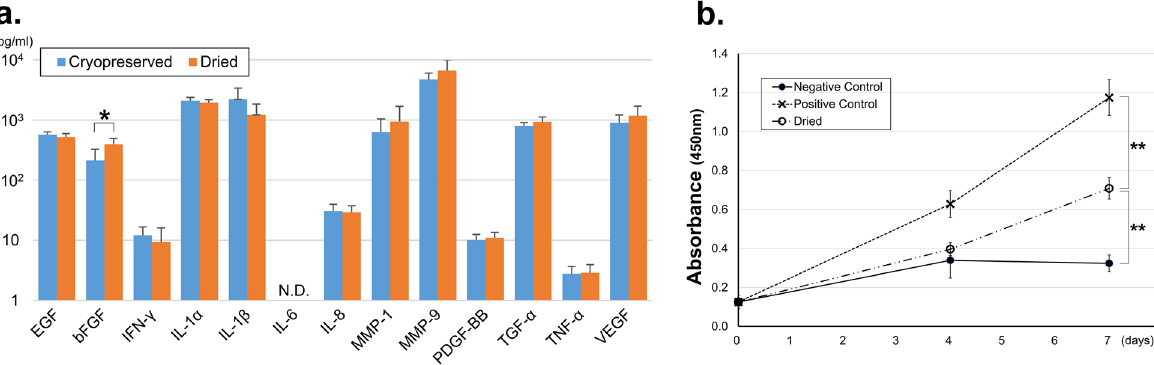
Figure 3. Amount of growth factors in dried CE and enhancement of keratinocyte proliferation by dried CE extracts. ( a ) Amount of growth factors and cytokines in CEs. Except for that in bFGF, the growth factor levels in the two types of CEs did not differ significantly (the amount of bFGF in dried CE was significantly higher than that in cryopreserved CE. * P < 0.05). The amount of IL-6 was less than the detection limit, and the amounts of IFN-γ and PDGF-BB were below the lower limit of quantification in both groups. (n = 5). ( b ) Absorbance correlated with keratinocyte proliferation in the WST-8 assay, which is exhibited on the vertical axis.